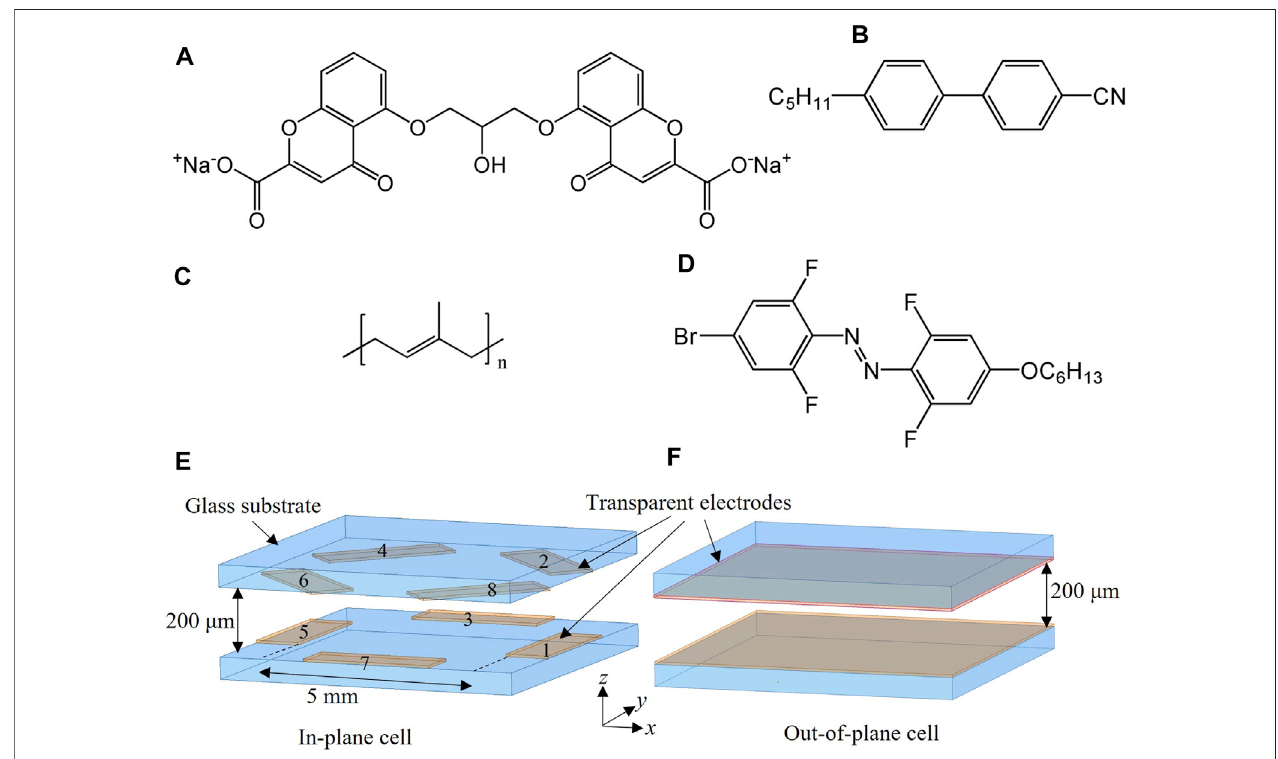
FIGURE 1 | Chemical structure of (A) DSCG, (B) 5CB, (C) polyisoprene, (D) azodye BrOTFAzoO 6 . (E) Geometry of the cell with patterned segmented electrodes. Fourelectrodesarelocatedoneachsubstrate.Thein-planeelectric fi eldisappliedwithintheelectrodesinthesameplate.Theschemeisnottoscale. (F) Geometryofthe cell with two transparent electrodes to apply an electric fi eld across the